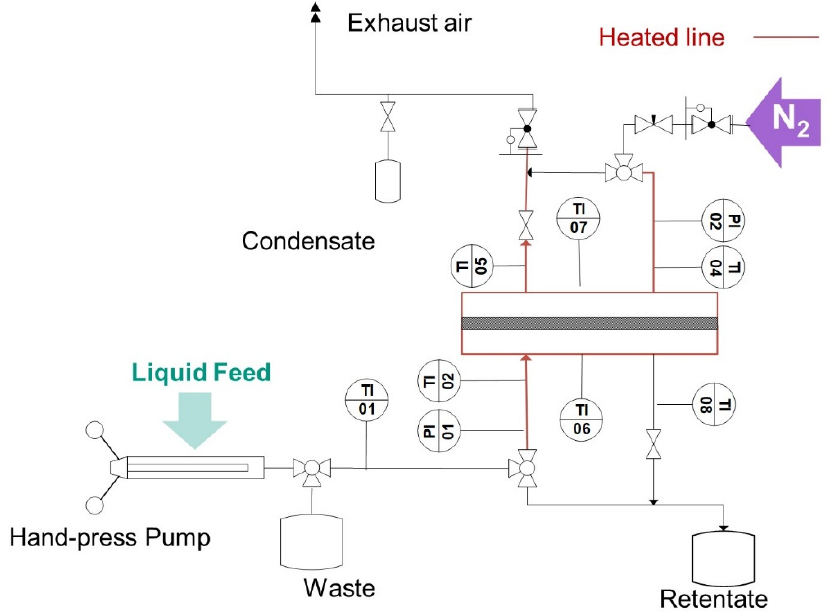
Figure 4. Overview of the experimental set-up used to measure the LEP using the Pressure Step Method.